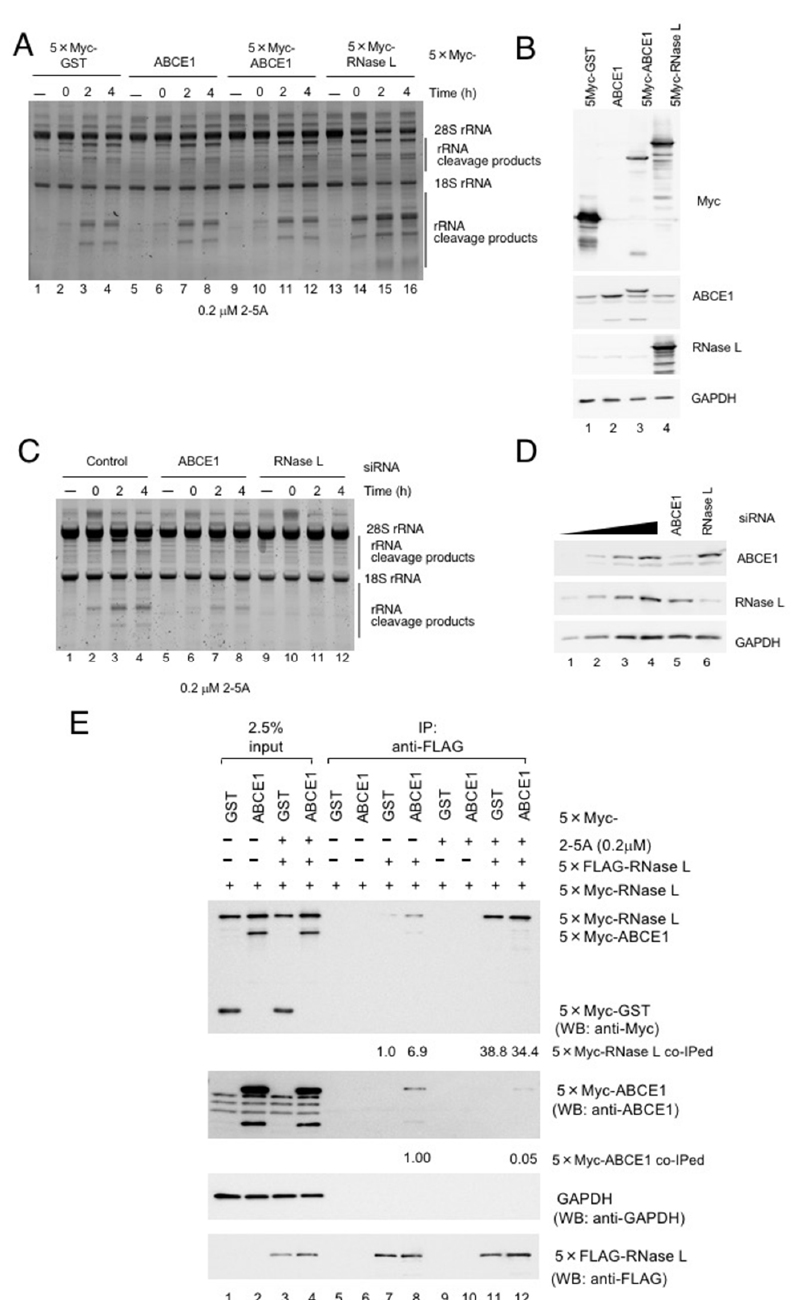
Figure 3. ABCE1 does not inhibit RNase L activity. ( A ) HeLa cells were transfected with p5×Myc-GST, pABCE1, p5×Myc-ABCE1 or p5×Myc-RNase L for 24 h, and the cells were further transfected with 2-5A (0.2 μM) using Neon TM Transfection System. rRNAs were analyzed by SYBR-Gold staining. ( B ) The levels of proteins in ( A ) were determined by western blotting. ( C ) HeLa cells were transfected with siRNA against either luciferase (control), ABCE1 or RNase L for 48 h, and the cells were further transfected with 2-5A (0.2 μM) using Neon TM Transfection System. rRNAs were analyzed by SYBR-Gold staining. ( D ) The levels of proteins in ( C ) were determined by western blotting. ( E ) HeLa cells expressing various combinations of the indicated proteins were lysed in buffer A and the lysates were rotated with anti-Flag M2 agarose in the presence or absence of 2-5A (0.2 μM). Proteins coprecipitating with 5×Flag-RNase L were analyzed by western blotting with the indicated antibodies ( n = 2).